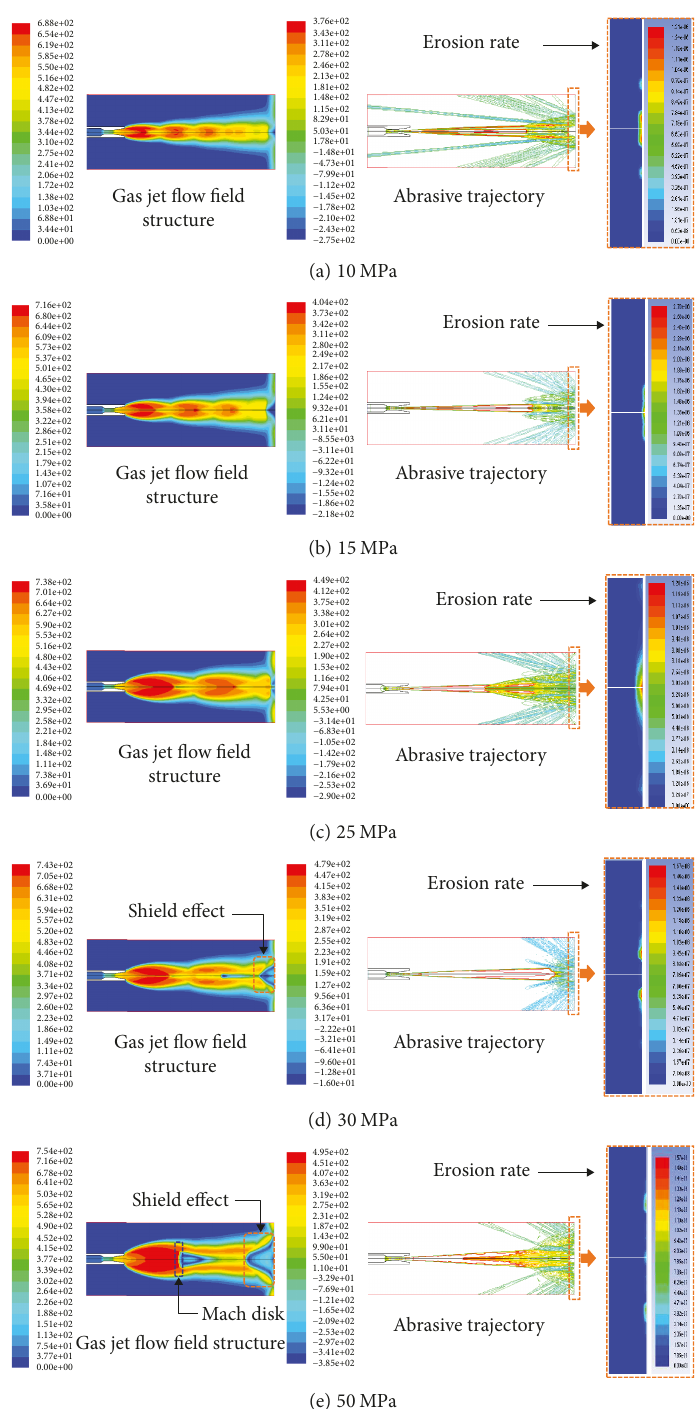
Figure 5: Flow fi eld of gas jet and erosion rate at a variable pressure of nozzle Mach